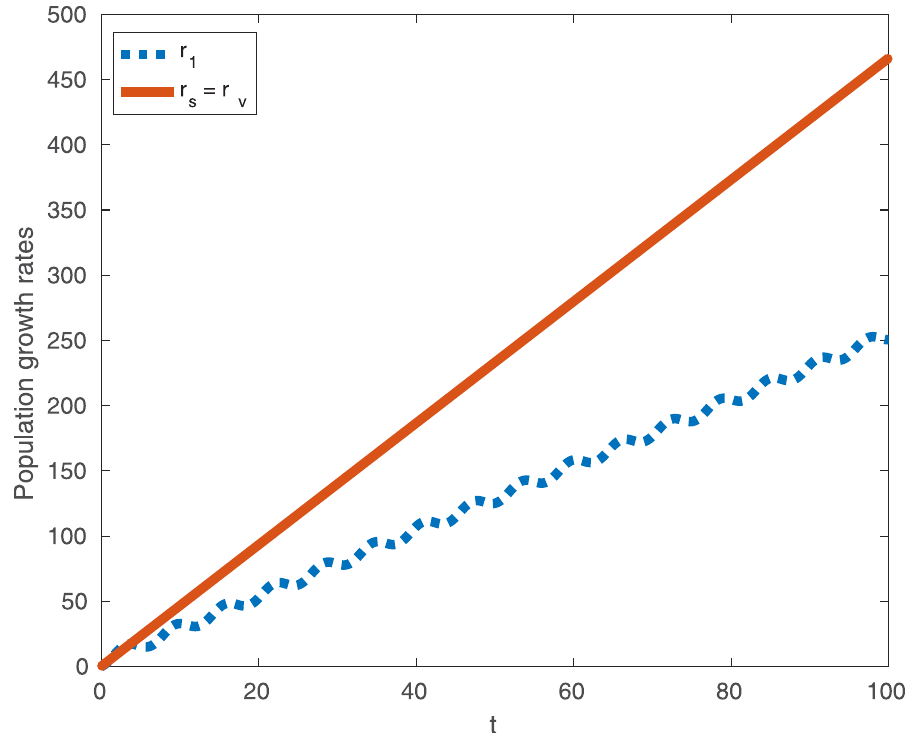
Fig 4. Typical population growth rates r 1 (dotted line), r 2 s (solid line) and r 2 v (coincides with r 2 s ) as a function of time when birth rates and mortality rates are variable. Observe that r 2 and g = π